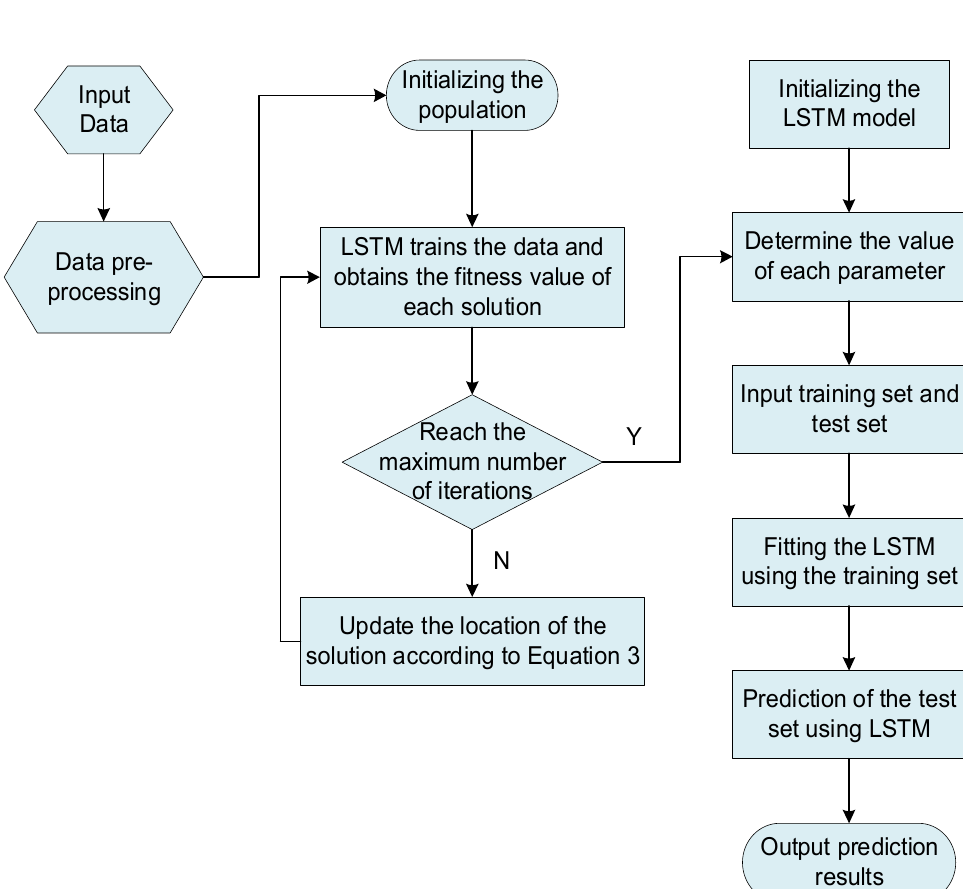
Figure 6. The MetaREC_LSTM solves the problem of electric load forecasting.